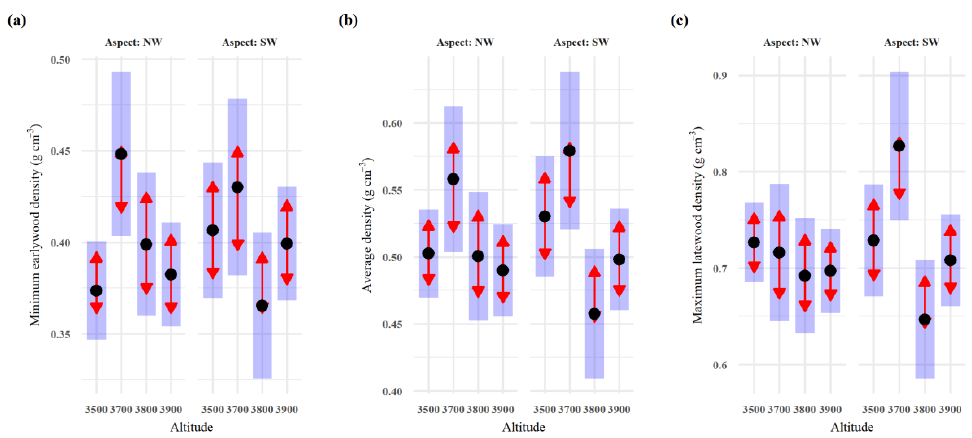
Figure 4. Graphical comparison for site condition (elevation × aspect) in tree-ring wood density variables ( a ) minimum earlywood density - MID, ( b ) average density - AVE, and ( c ) maximum latewood density - MXD. Blue bars represent confidence intervals for estimated marginal means or least-square means, and red arrows allow comparisons among them. When arrows overlap differences are not significant ( p > 0.05).